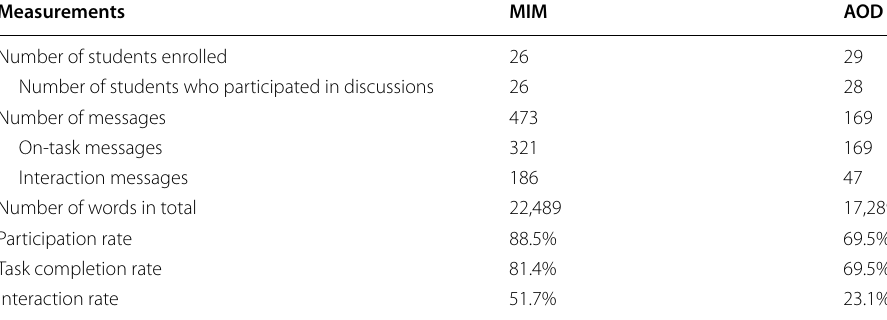
Table 4 Differences in behavioral